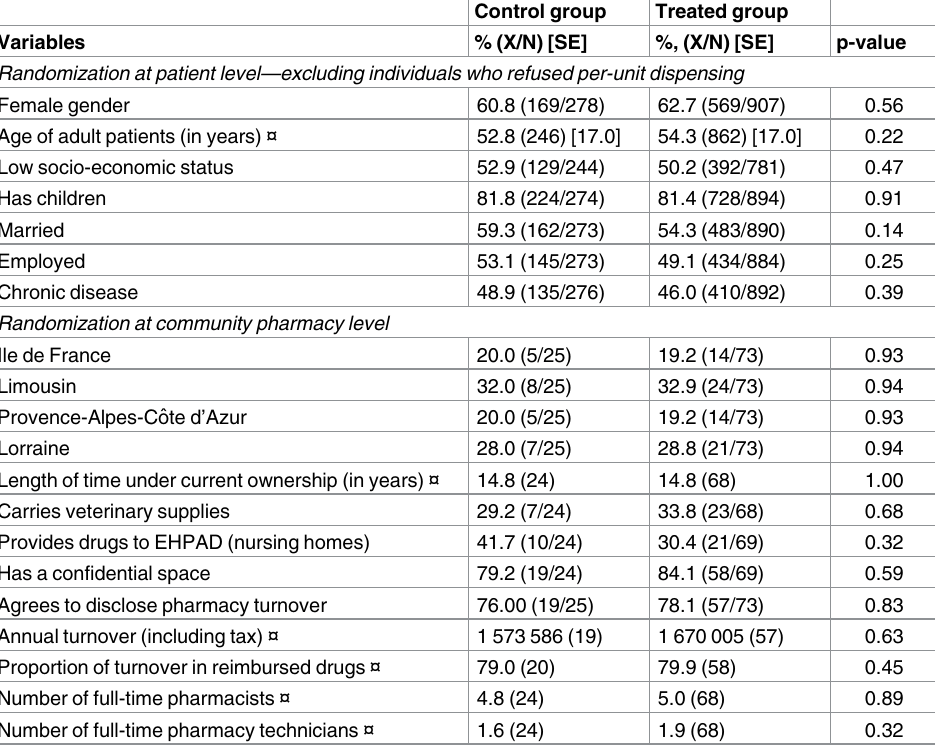
Table 1. Patient and community